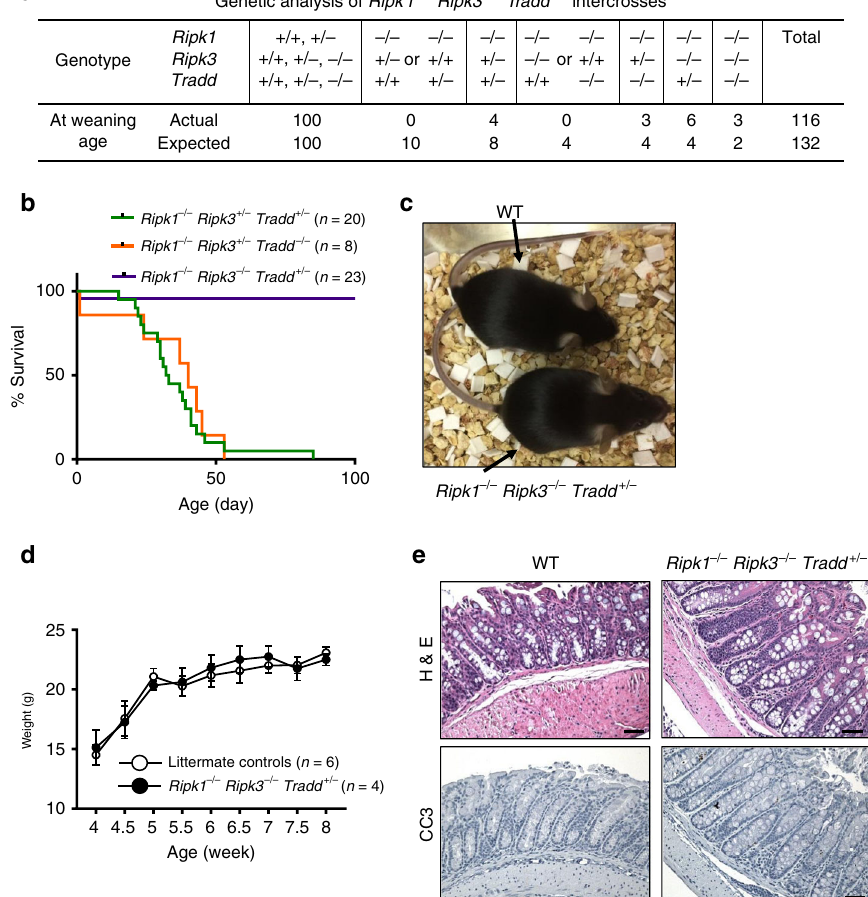
Fig. 2 Haplosuf fi ciency of TRADD rescues the lethality of Ripk1 − / − Ripk3 − / − mice. a Expected and actual frequencies of pups at weaning age from a triple heterozygous cross of Ripk1 + / − Ripk3 + / − Tradd + / − mice. b Kaplan-Meier plot showing survival of mice of indicated genotypes. Logrank tests showed Ripk1 − / − Ripk3 − / − Tradd + / − mice exhibited improved survival over Ripk1 + / − Ripk3 − / − Tradd + / − and Ripk1 − / − Ripk3 + / − Tradd − / − mice ( p < 0.0001). c One month old mice of indicated genotypes ( n = 5 independent experiments). d Weights of Ripk1 − / − Ripk3 − / − Tradd + / − mice and littermate controls over time presented as mean ± SEM. t test shows no signi fi cant difference between groups. e H&E and cleaved caspase 3 (CC3) staining of the large intestine of indicated genotypes ( n = 3 independent experiments). Scale bars are 50 μ (Supplementary Fig. 5b, c). Flow cytometric analysis indicates that the spleen of Ripk1 − / − Ripk3 − / − Tradd − / − mice contain an increased Mac + Gr1 + myeloid cell population (Supplementary (Fig. 2e), unlike Ripk1 − / − Ripk3 − / − Tradd − / − mice, which show greatly elevated active caspase 3 Fig. 6,a). The thymus is signi fi cantly reduced by size and weight levels in the large intestine (Fig. 1e). Ripk1 − / − Ripk3 − / − Tradd + / − (Supplementary Fig. 5b, c) and thymic cellularity was also greatly mice older than 6 months display no enlargement of the decreased compared with WT controls (Supplementary Fig. 5d). lymphoid organs (Supplementary Fig. 4a) nor presence of the abnormal CD3 + B220 + population (Supplementary Fig. 4b), the typical symptoms of lymphoproliferative ( lpr ) disease present in Fas − / − mice. This contrasts the severe lpr phenotype in Fadd − / − Ripk3 − / − or Fadd − / − Ripk3 − / − Ripk1 − / − mice shown previously by others and us (Supplementary Fig. 4) 29,32 – 34 .